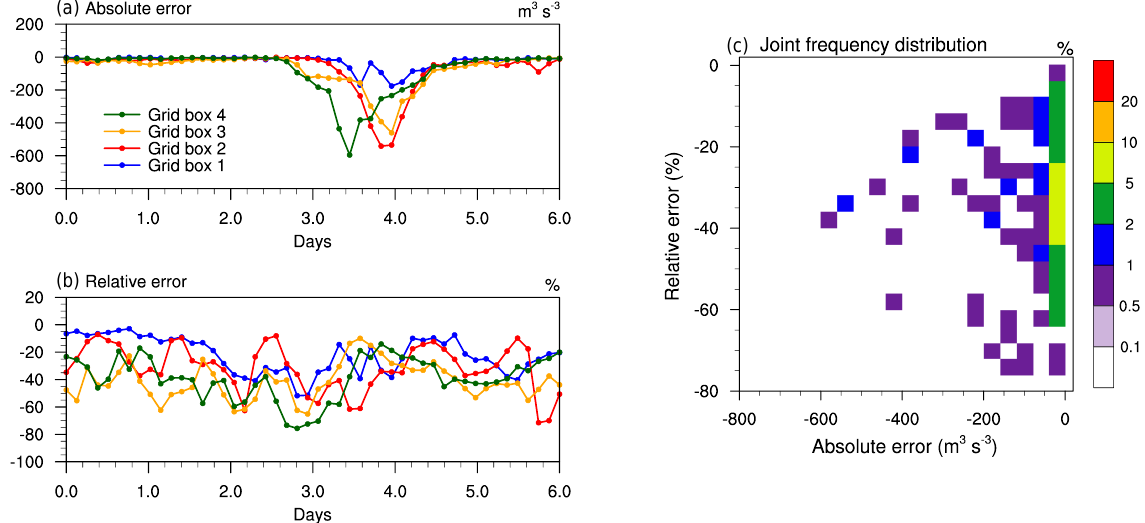
Figure 6. As in Fig. 4 but for the WRF simulation over Western China, and for the error of U 3 10 . The errors are calculated for Eq. (12) assuming Eq. (13) is the “truth”.